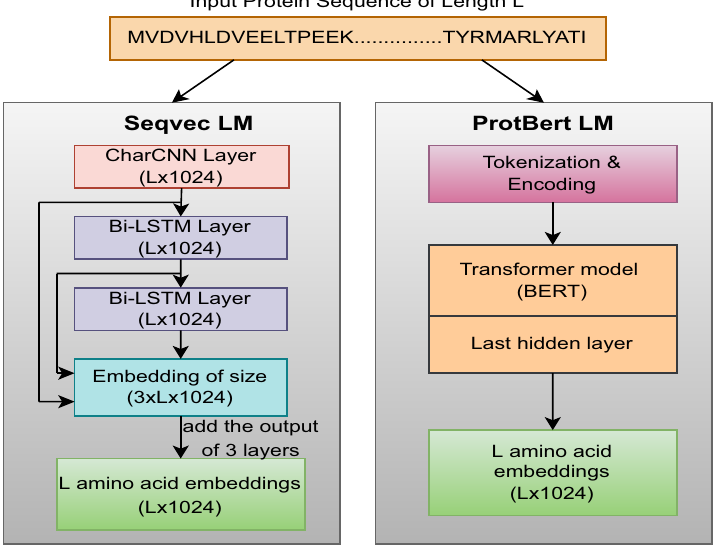
Figure 3. Illustration of the feature extraction from protein sequence using language